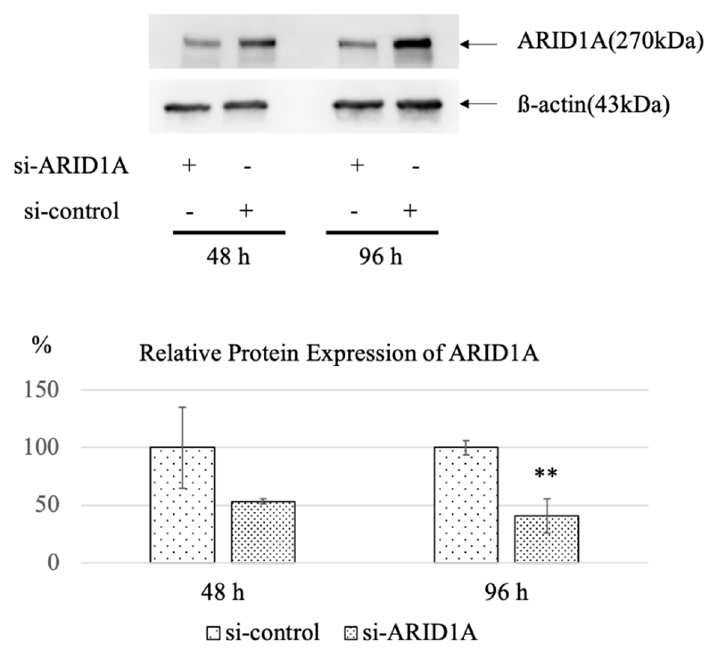
Figure 1. Knockdown efficacy of ARID1A interference to RMG-I. Effective interference of ARID1A was confirmed at 96 h by 5 nM of the siRNA ( n = 3 per group). The graphs are described by mean (SD). ** p < 0.01 vs. control.